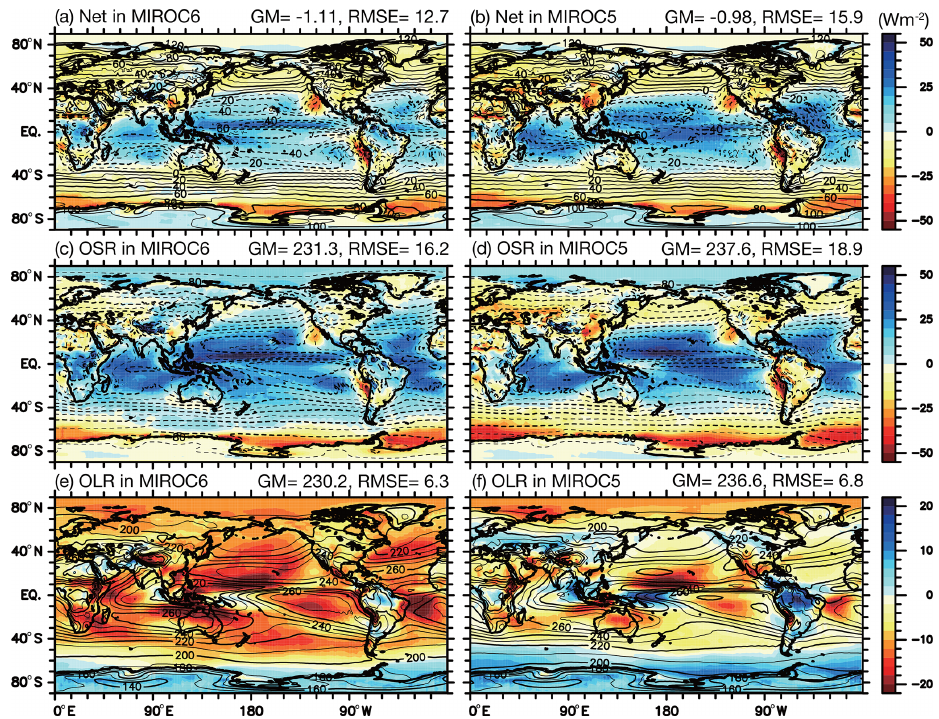
Figure 4. Annual mean TOA radiative fluxes in MIROC6 (a, c, e) and MIROC5 (b, d, f) . Upward is defined as positive. Net shortwave and longwave radiative fluxes and the sum of the two fluxes are denoted as OSR, OLR, and NET, respectively. Colors indicate errors with respect to observations (CERES) and contours denote values in each model. Note that a different color scale is used for longwave radiation. The global mean values and root mean squared errors are indicated by GM and RMSE, respectively. In the present paper, RMSE is computed without model and observed global mean quantities unless otherwise